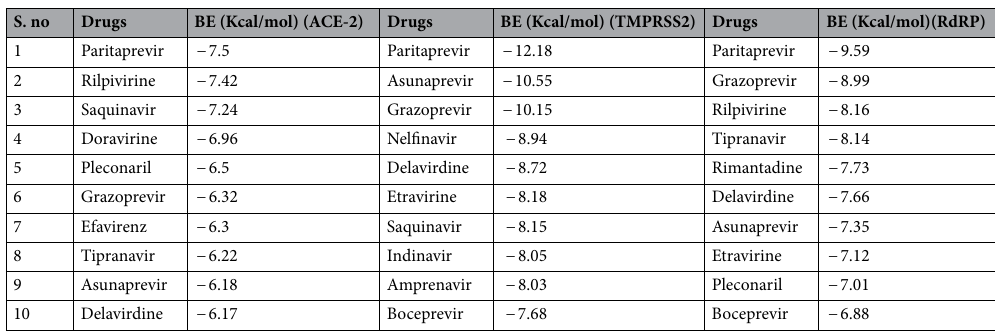
Table 1. Binding Energy of top ten ligands to the respective